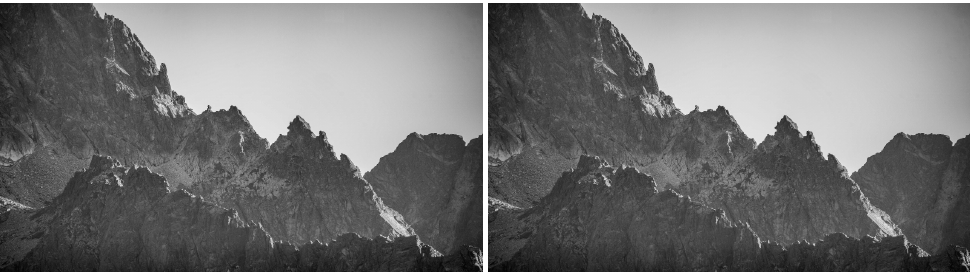
Figure 17. Comparison of output images obtained with constant ( left ) and adaptive ( right ) limit β . The difference between them is hardly noticeable for the considered